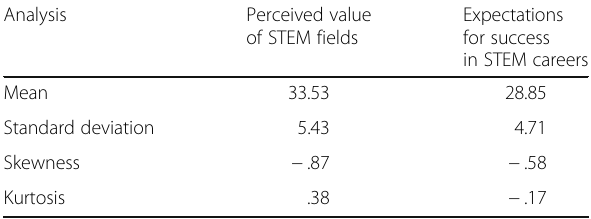
Table 4 Summed-scale distributions for VESAS